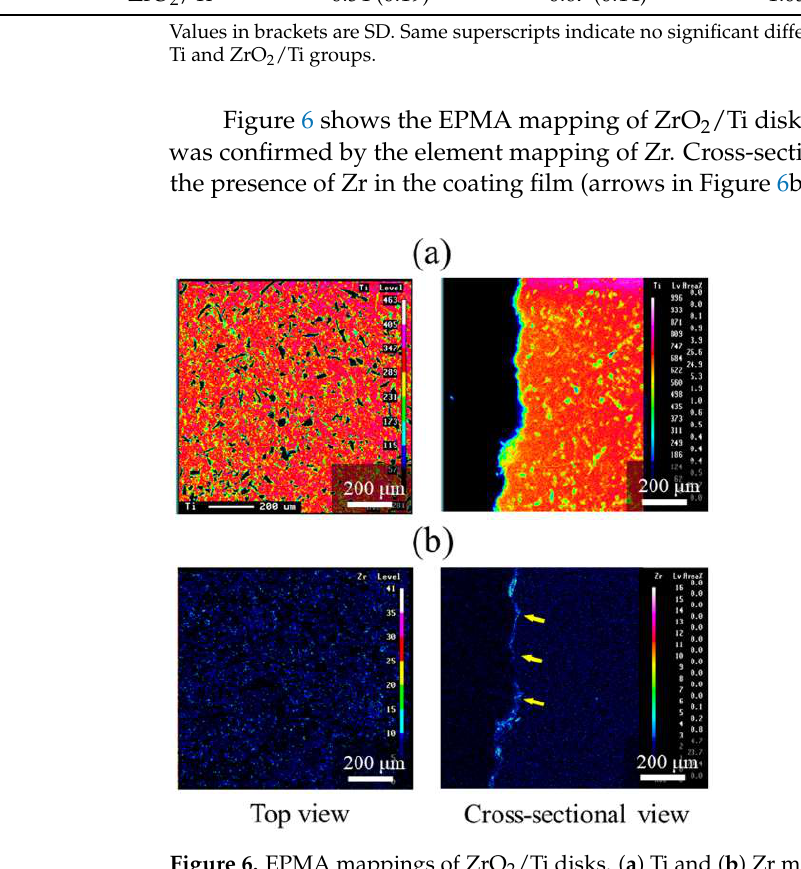
Figure 6. EPMA mappings of ZrO 2 /Ti disks. ( a ) Ti and ( b ) Zr mappings. The arrows on ( b ) indicate Zr elements.